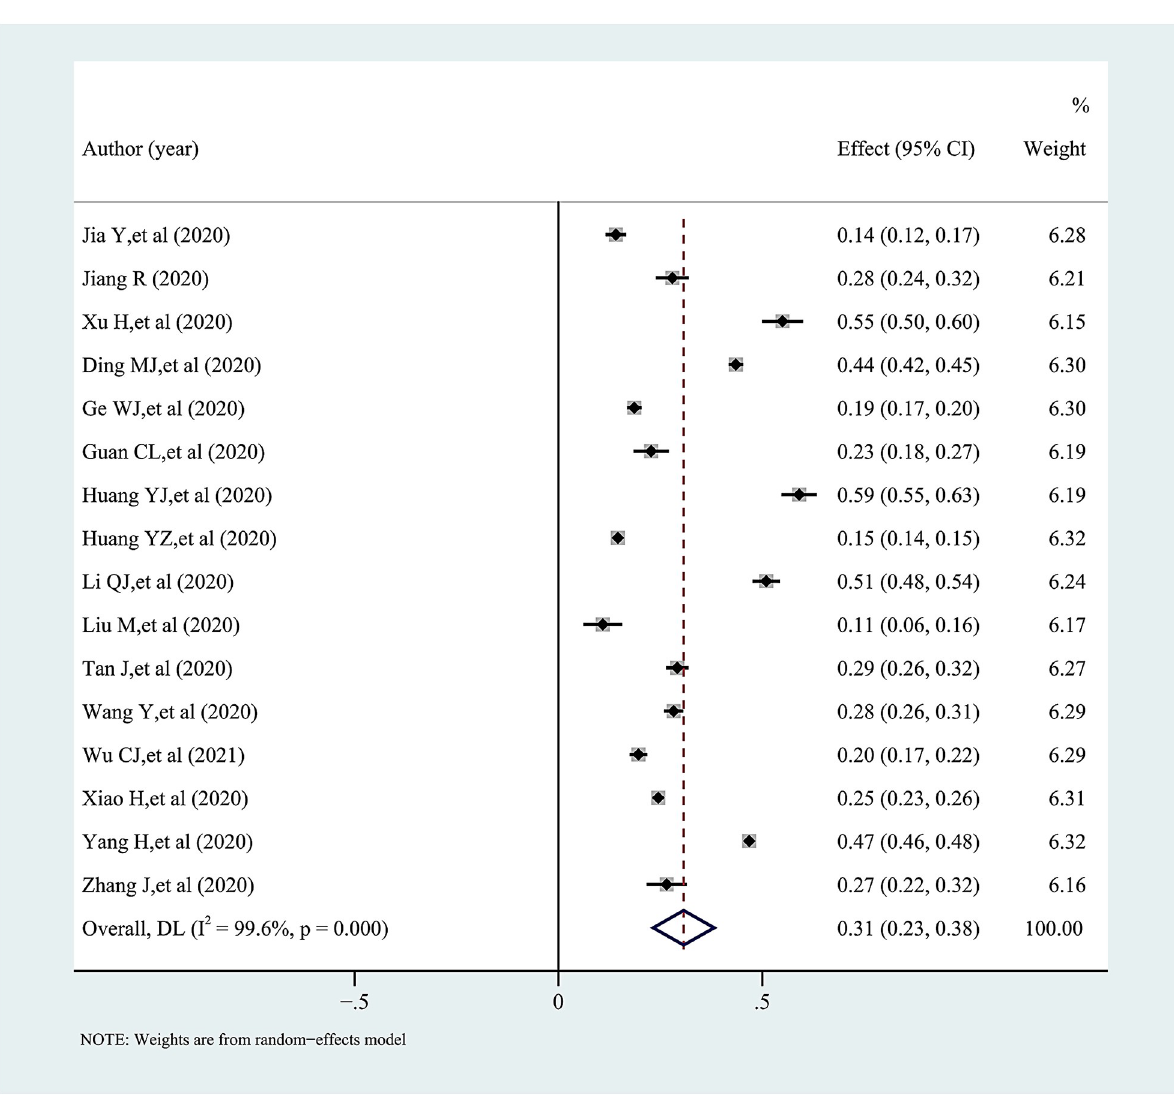
Fig 4. Forest plot showing the pooled proportion of negative attitudes towards COVID-19 among study participants.